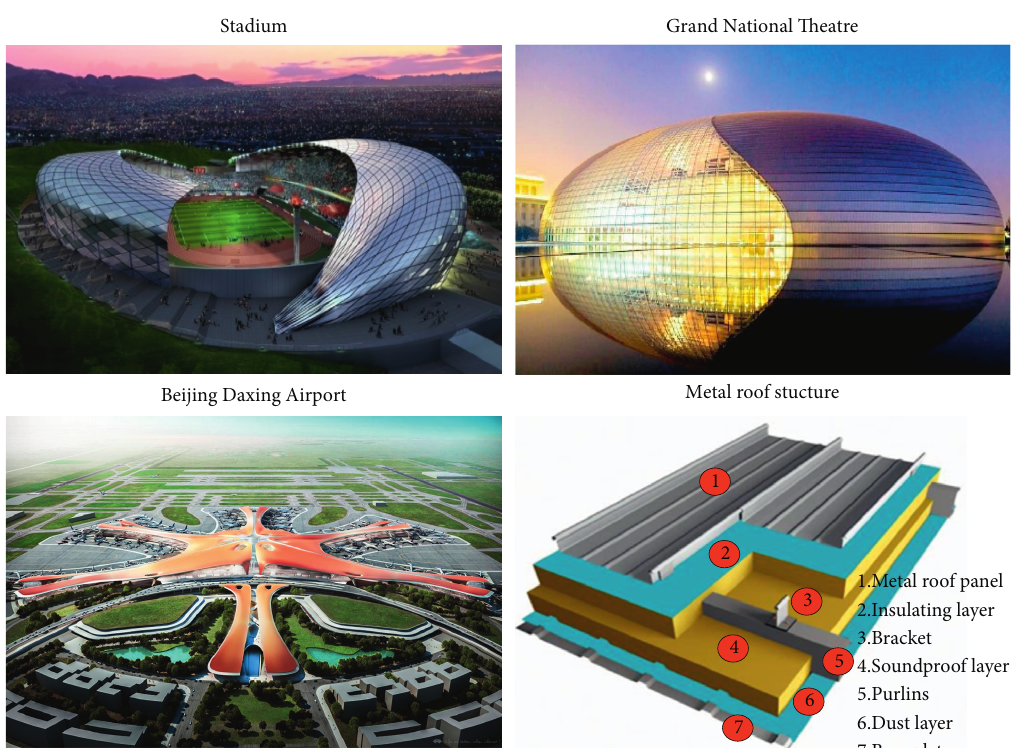
Figure 1: Widely used metal roof enclosure system.